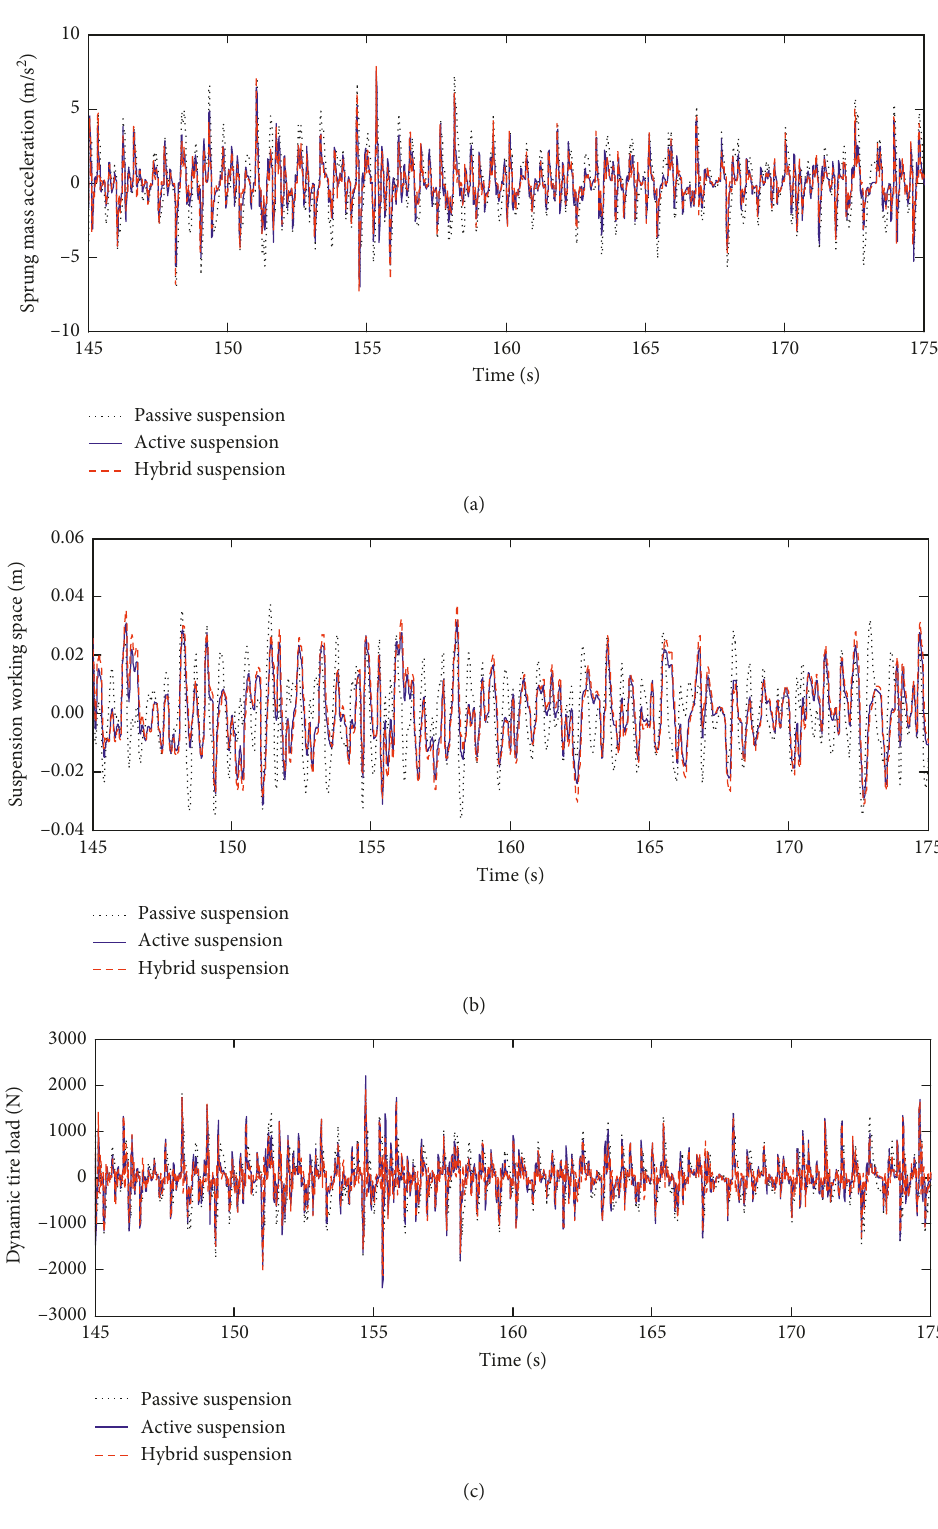
Figure 20: The dynamic responses of the hybrid suspension. (a) The response curves of sprung mass acceleration. (b) The response curves of suspension working space. (c) The response curves of dynamic tire